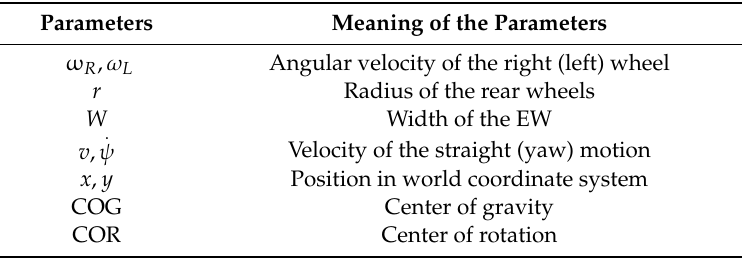
Figure 3. Top view of the proposed EW model. Table 1. Parameters of the EW model.